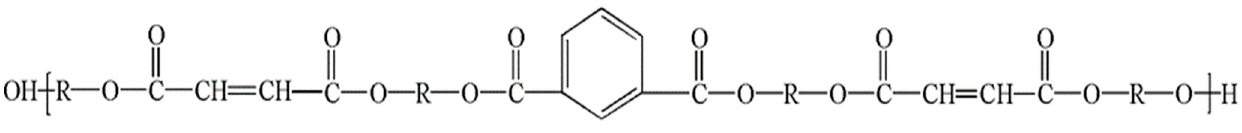
Figure 1. Unsaturated polyester oligomer.